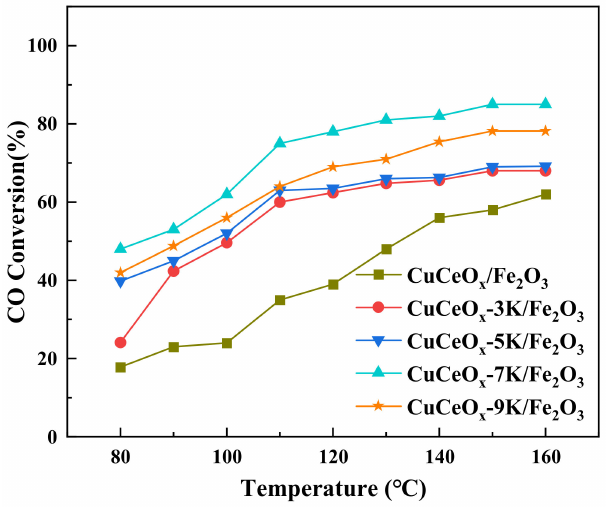
Figure 1. CO conversion of CuCe-xK/Fe 2 O 3